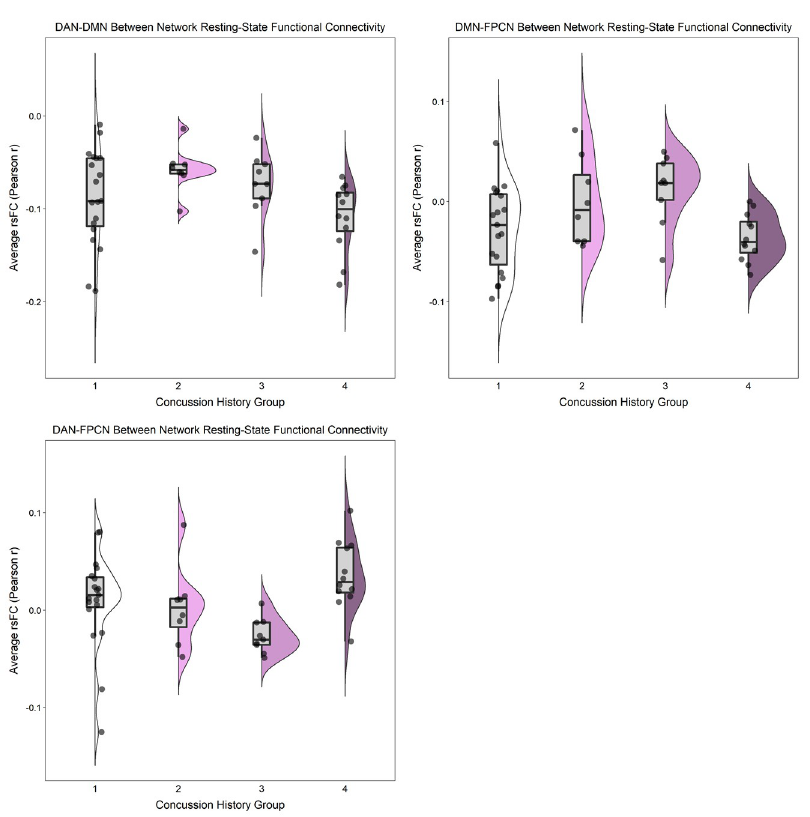
Fig 4. Between-network resting-state functional connectivity (rsFC) in large-scale networks separated by four ordinal concussion history groups. Between-network rsFC was calculated as the average Pearson r correlation (y- axes) between each of the individual ROIs from one specific network and all individual ROIs in another specific network across the time-series: Dorsal Attention Network and Default Mode Network (top-left); Default Mode Network and Frontoparietal Control Network (top-right); and Dorsal Attention Network and Frontoparietal Control Network (bottom). Individual points represent participant-level outcomes for each measure within each of the concussion history groups (1 = 0 or 1 concussion [ n = 19]; 2 = 2 to 4 concussions [ n = 8]; 3 = 5 to 7 concussions [ n = 9]; and 4 = 8 or more concussions [ n = 12]). Boxplots represent the median and interquartile range, and the whiskers extend to 1.5 times the interquartile range. The violin plot is a depiction of the density of individual rsFC values for each